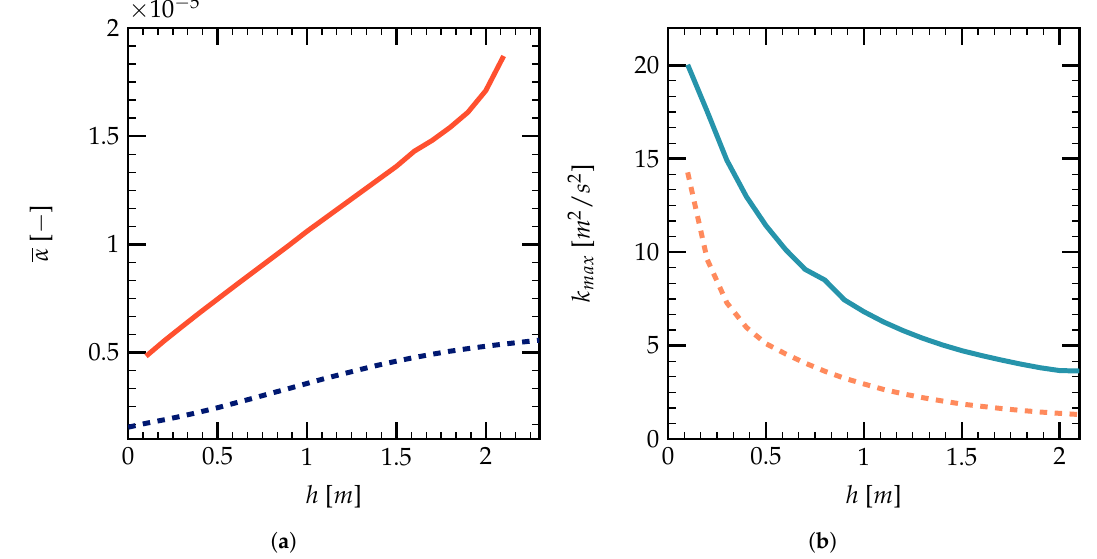
Figure 17. ( a ) Evolution of the surface averaged droplet volume fraction α as a function of h : tow nozzles ( ) and single nozzle ( ); ( b ) evolution of k max as a function of the vertical distance h : two nozzles ( ) and single nozzle (